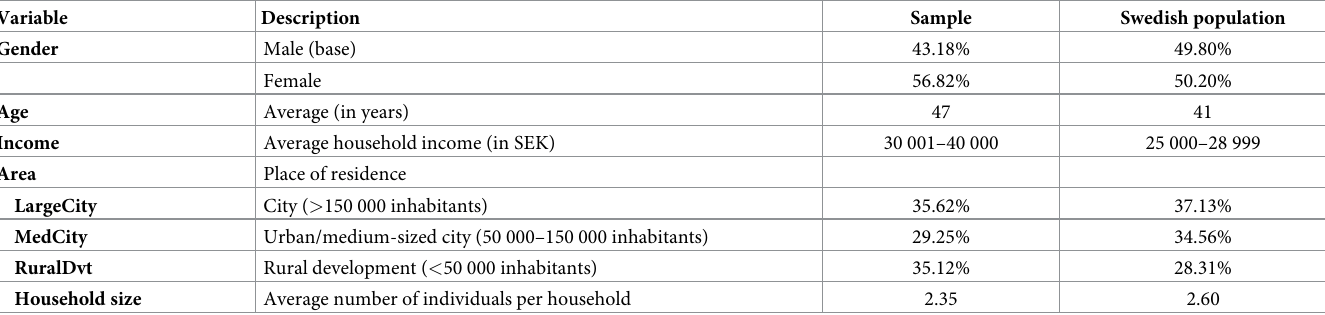
Table 1. Socio-demographic characteristics of the study sample and of the Swedish population as a